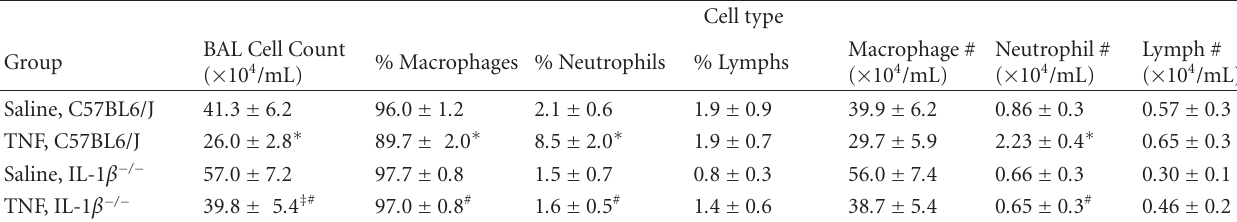
Table 1: Cell count and di ff erential of bronchoalveolar lavage harvested six hours after oropharyngeal delivery of TNF alpha or control saline. BAL: bronchoalveolar lavage; Lymphs: lymphocytes. Treatment groups represent 8–15 mice/group. ∗ P ≤ . 05 TNF versus saline, C57BL6/J treatment groups; ‡ P ≤ .05 IT TNF versus Saline, IL β − / − treatment groups; # P ≤ . 05 IT TNF, IL-1 β − / − versus WT treatment groups. Values are means ± SEM, n = 8 − 15